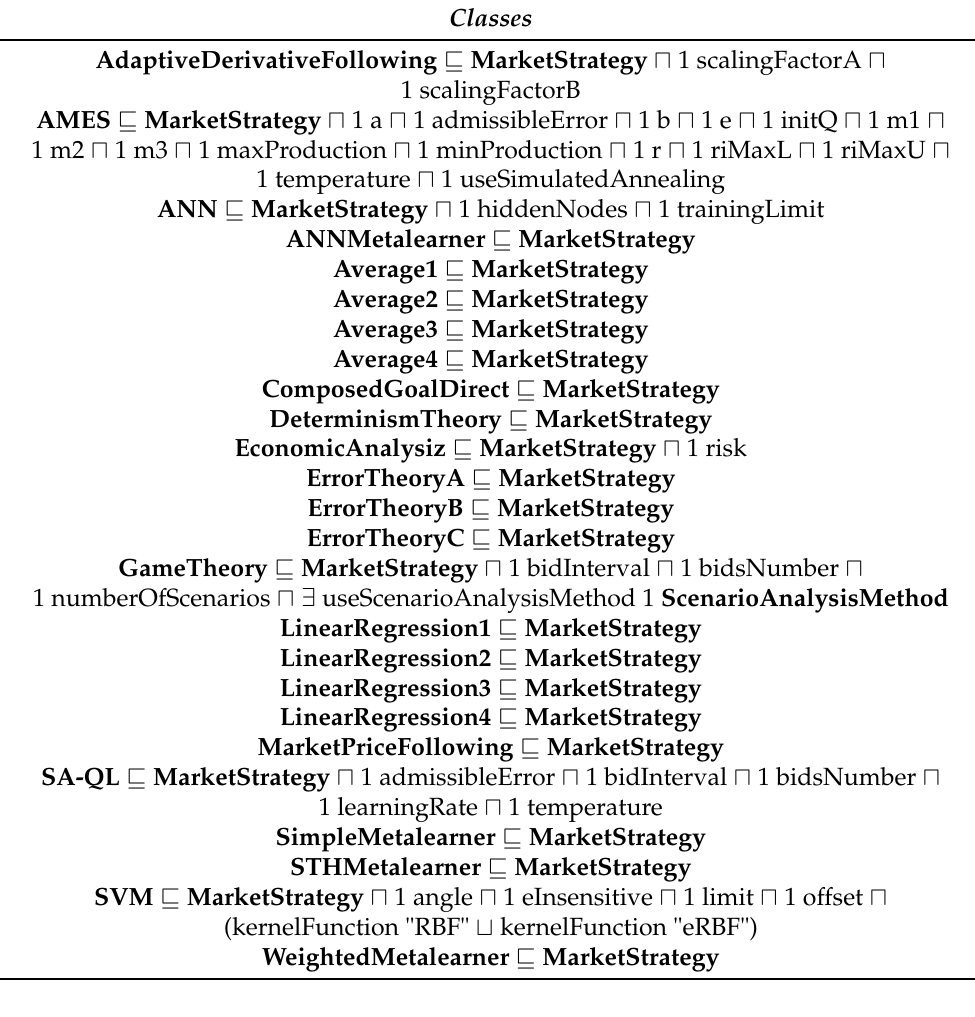
Table 5. AiD-EM Ontology MarketStrategy ’s sub-classes in DL syntax.